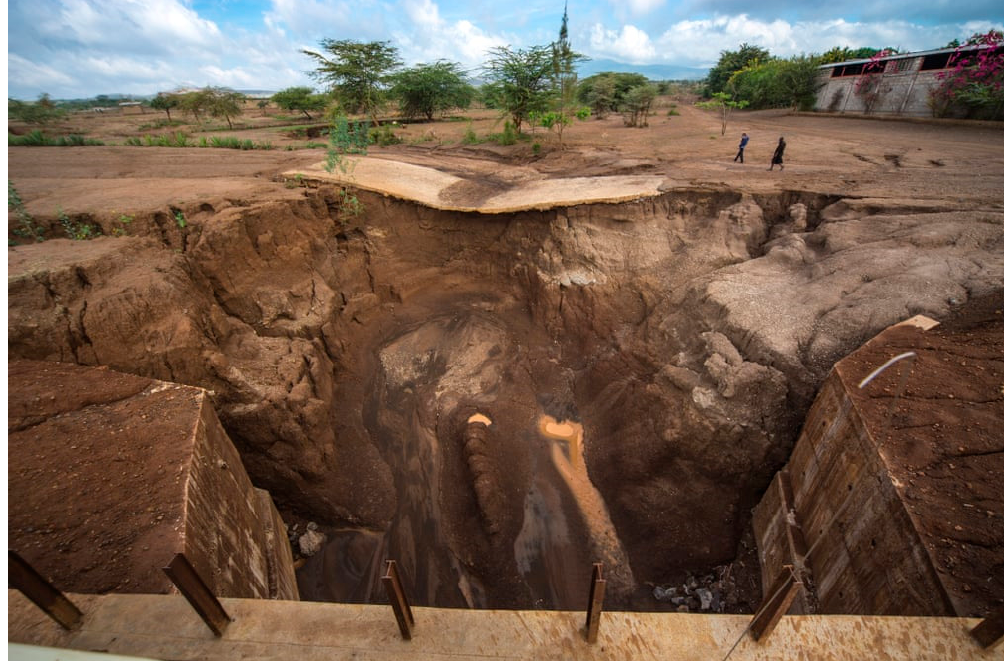
Figure A2. Impactsofsoilerosionprocessesoncommunityinfrastructure. Source: CareyMarks / University Figure A2. Impacts of soil erosion processes on community infrastructure. Source: Carey of Marks/University of Plymouth.